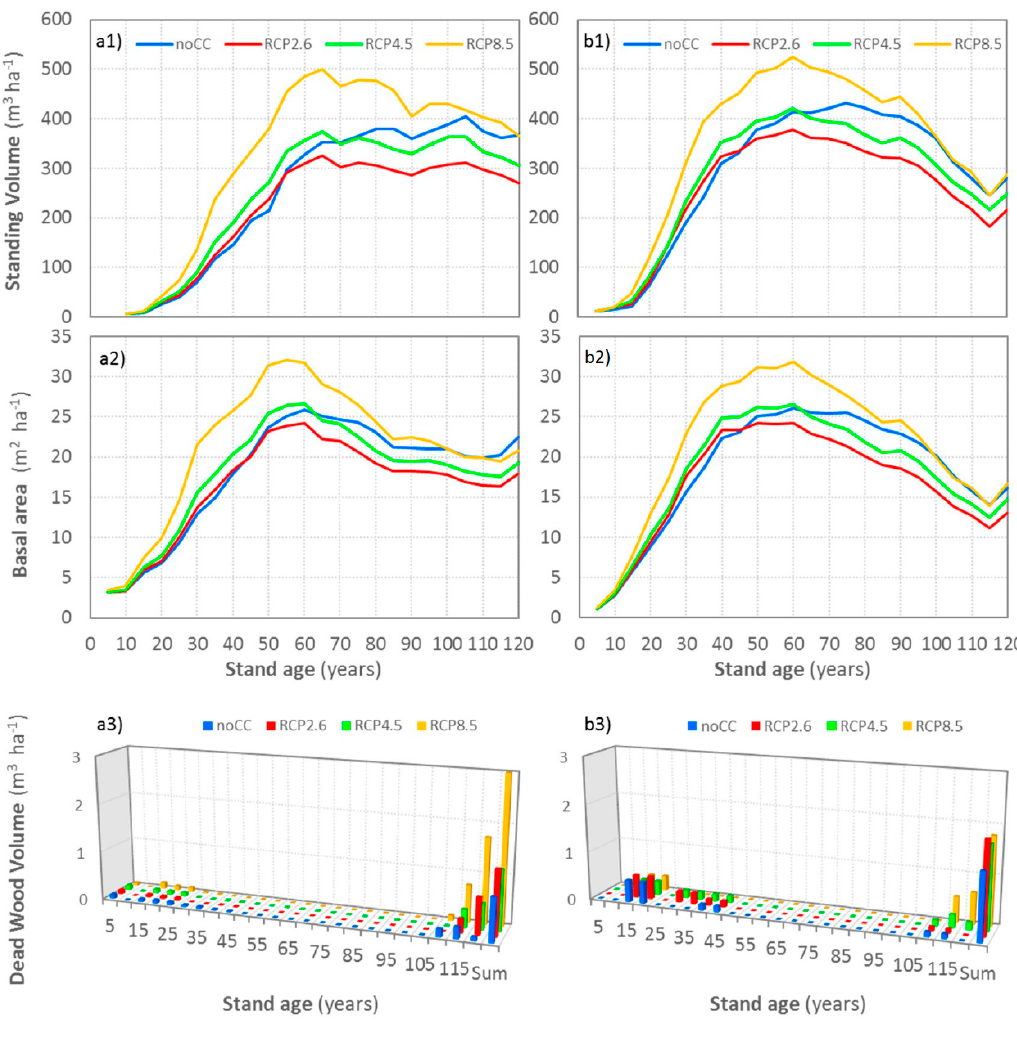
Figure 6. Effects of four climate scenarios (noCC, RCP2.6, RCP4.5, RCP8.5) on standing volume (1), basal area (2) and dead wood volume (3) of beech ( a1 – a3 ) and fir ( b1 – b3 ). For the noCC scenario, a climate file of 120 was generated with an in-built weather generator in GOTILWA + using climate data of the past 40 years from a nearby meteorological weather station with constant CO 2 concentration (370 ppm—global mean of 2018). For the three climate change scenarios RCP2.6, RCP4.5 and RCP8.5, changes in temperature, precipitation and CO 2 were applied to the generated climate file according to the MPI-ESM-LR global circulation